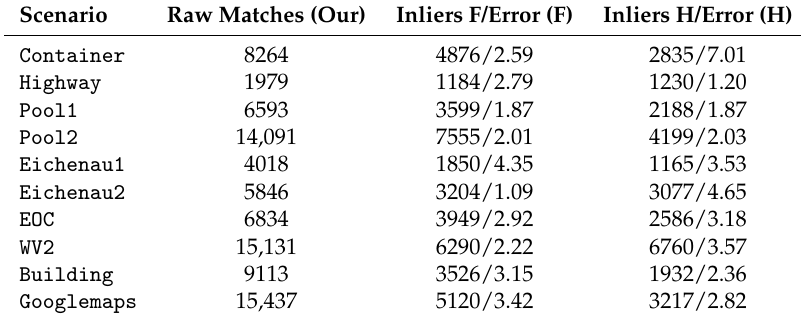
Table 8. Results using the proposed method: number of raw matches after applying our method for all scenarios. Inliers after estimating fundamental matrix (F) and homography (H) using RANSAC. Mean errors (in pixel) according to ground-truths F and H.